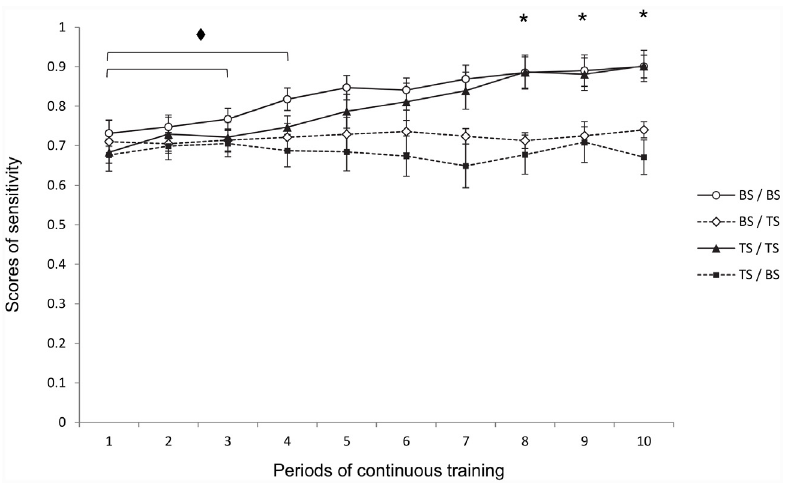
Fig 3. Effect of the type of scent combination used during continuous training on sensitivity scores. Sensitivity scores represent the proportion of correct detections (number of Hits / [Hits + Misses]). Each curve represents the evolution of scores ( ± S.E.M.) according to period. Intergroup comparison: * indicates P < 0.05 between BS / BS; TS / TS versus BS / TS and TS / BS in periods 8 to 10. Intragroup comparison: ♦ indicates P < 0.05 compared to scores obtained in other periods for BS / BS and TS /